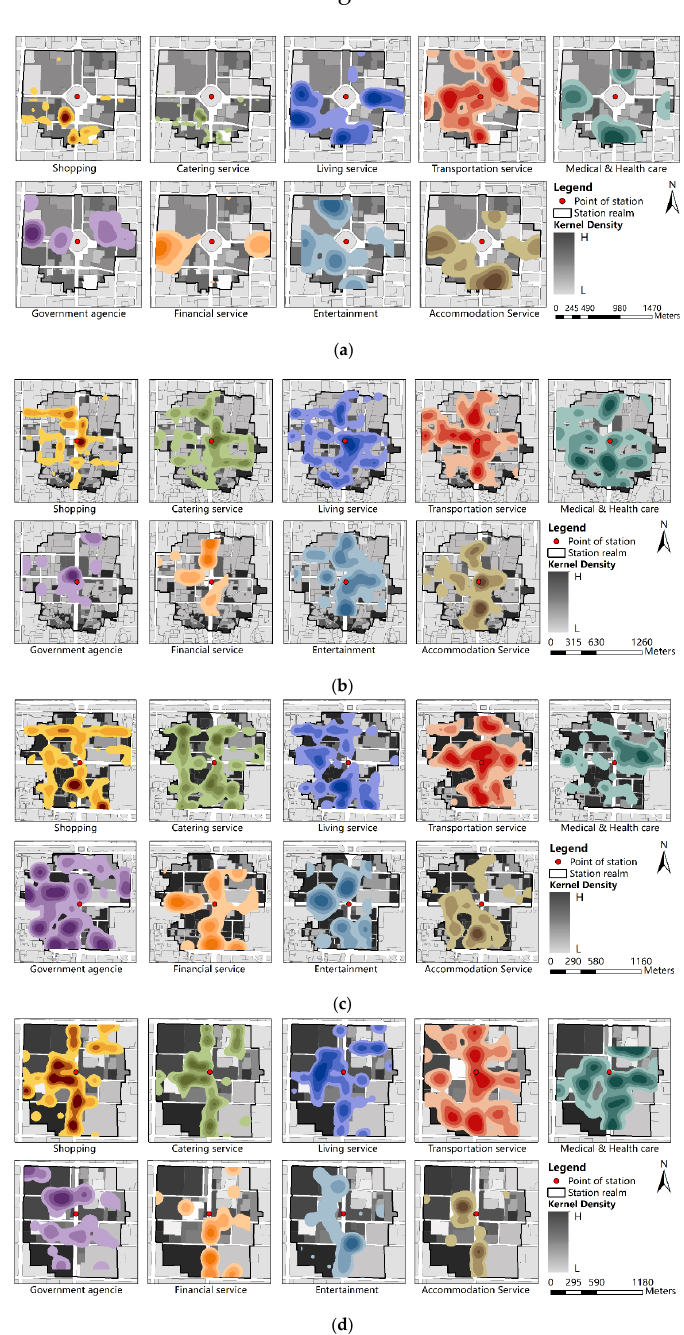
Figure 13. Kernel density analysis of each functional POI in study station realm. The analysis results of the ( a ) XXZX Station; ( b ) LSY Station; ( c ) BDJ Station; ( d ) WYJ Station. As shown in Figure 13a, the POIs of various functions in the Xing Zheng Zhong Xin station realm show a spatial distribution feature of high in the south and low in the north. The POIs of various functional facilities in the Long Shou Yuan station realm are generally distributed around the station (Figure 13b), especially the six types of facilities, namely shopping POIs, catering POIs, living POIs, transportation POIs, government agency POIs, and accommodation POIs, which have the characteristic of higher density the closer they are to the station. As shown in Figure 13c, the distribution features of each functional fa- cility in the Bei Da Jie station realm differ significantly. Five types of facilities, namely